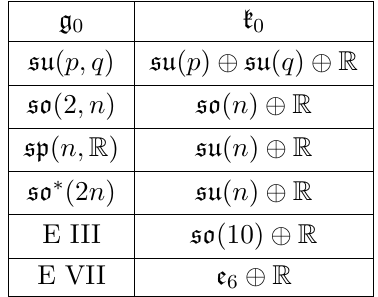
Table 8 . The Hermitian symmetric pairs ( g 0 ; k 0